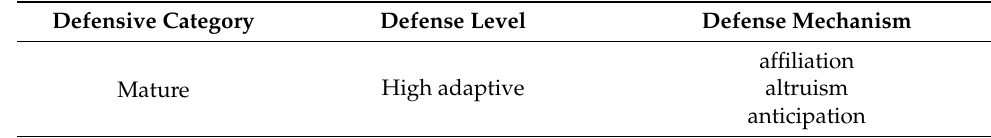
Table 1. DMRS-SR-30 quantitative scoring